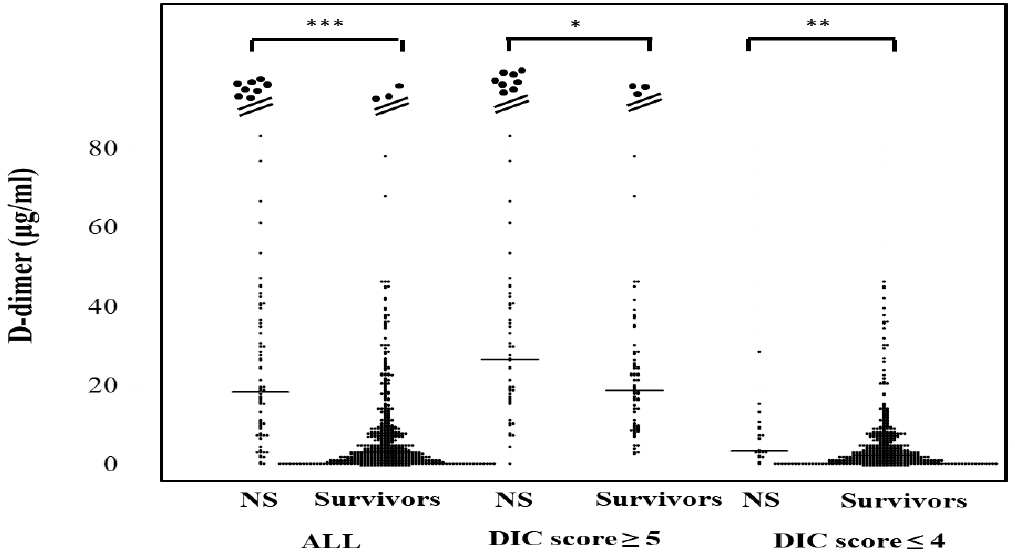
Figure 4. D-dimer levels in survivors and non-survivors. NS; non-survivor; * p < 0.05; ** p < 0.01; *** p < 0.001; NS. not significant.